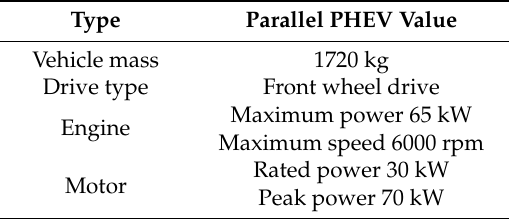
Table 1. Vehicle